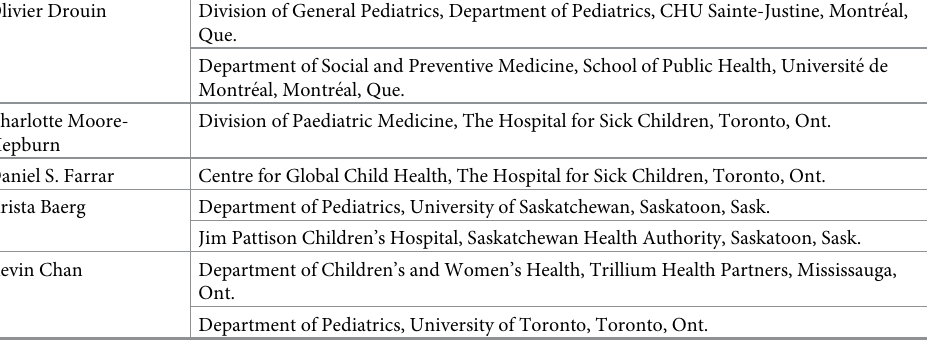
S1 Table. SARS-CoV-2 CPSP severity criteria. S2 Table. Symptoms, laboratory findings, and clinical syndromes of infants with SARS- CoV-2 infection by age group. S3 Table. Logistic regression sensitivity analysis of factors associated with hospital admis- sion due to COVID-19-related disease. S4 Table. Characteristics of infants with SARS-CoV-2 infection reported from the Centre Hospitalier Universitaire Sainte-Justine, Hospital for Sick Children, or Montreal Chil- dren’s Hospital. S5 Table. Comparison of CPSP and modified Dong severity criteria. S6 Table. Characteristics of admitted infants with severe COVID-19. S7 Table. Treatments administered to infants with COVID-19.